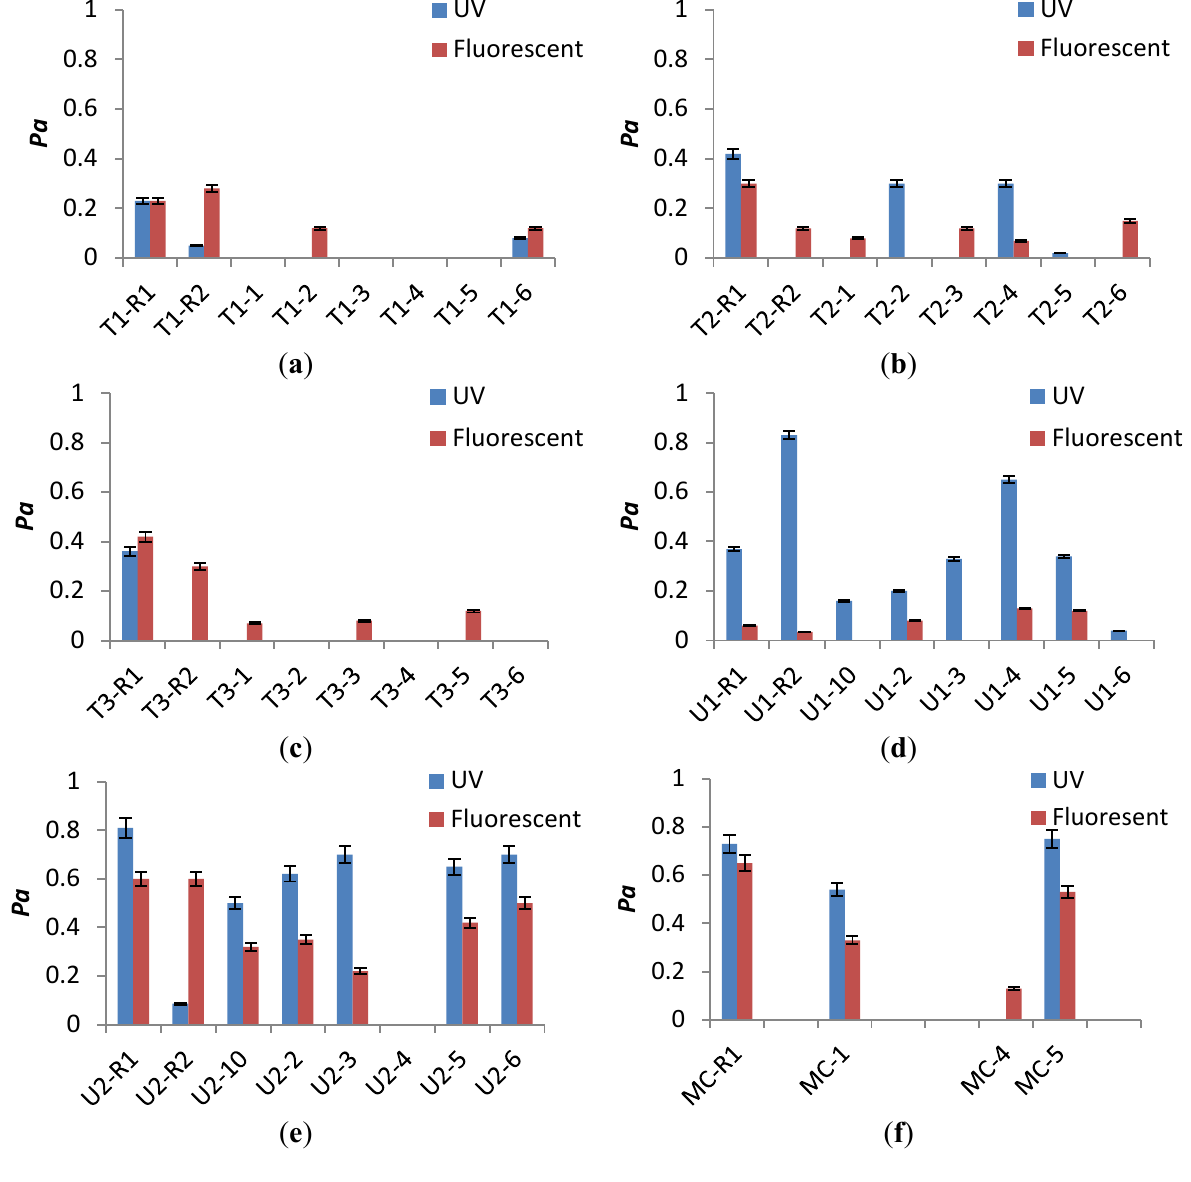
Figure 8. Photoactivity of TiO fluorescent light (red bars) irradiation. ( a ) T1; ( b ) T2; ( c ) T3; ( d ) U1; ( e ) U2; ( f )